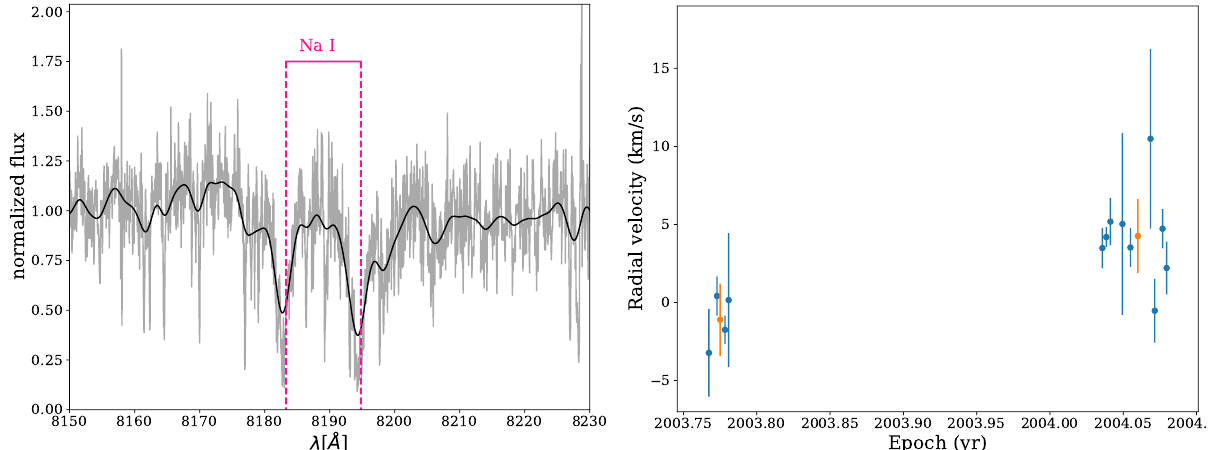
Fig. 4.— Left: Example spectrum obtained with UVES at ESO/VLT on October 8 2003. The grey line is the reduced spectrum, the black line the same convolved with a Gaussian with a standard deviation of 0.8Å. The rest-frame wavelengths of the Na doublet used for measuring radial velocities are marked. Right: Radial velocity measurements over time (blue) and the averages for the two groups of epochs (orange).